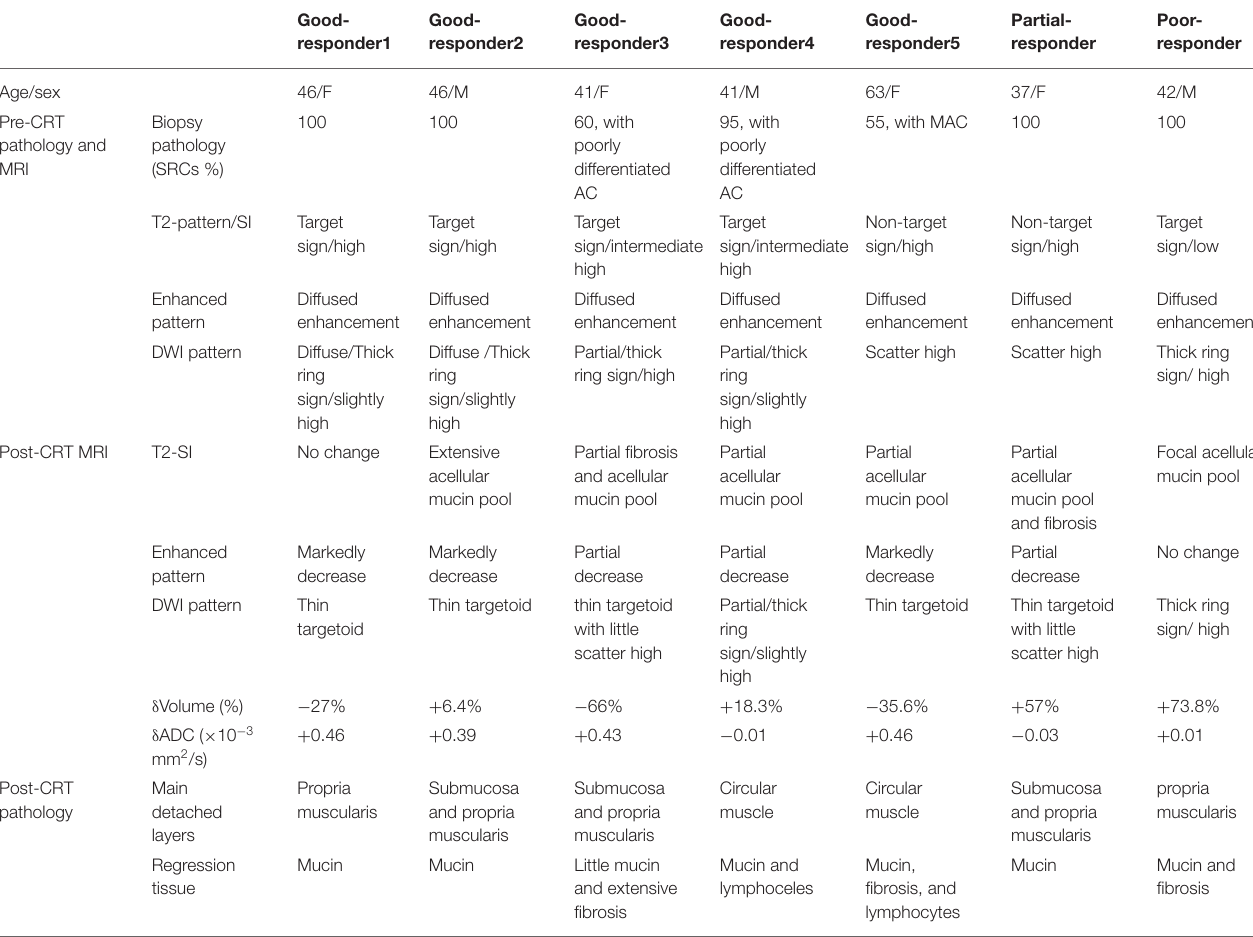
TABLE 1 | The main clinical, image features, and pathology information pre and post-CRT.